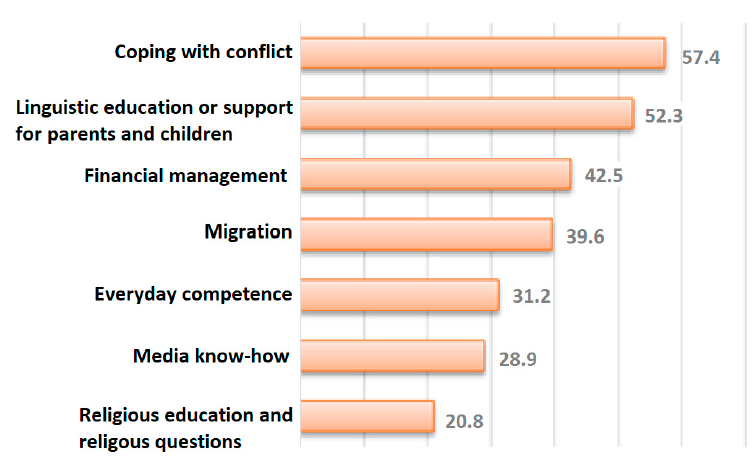
Figure 4. Subcategories of interest in offers for promoting competences (percentage of all valid answers, multiple nominations; percentage data). (Source: Authors, 2020).